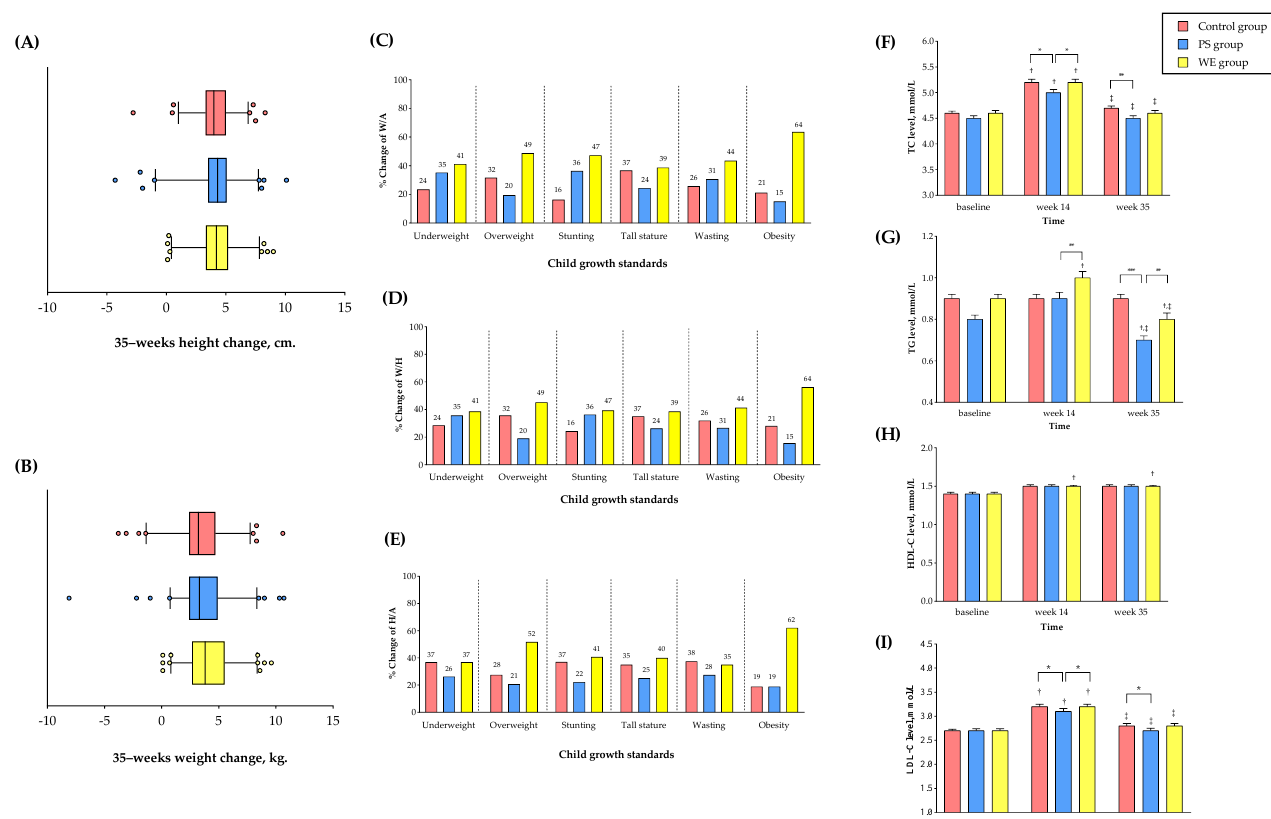
Figure 2. Anthropometrics and plasma lipid levels change in study group. ( A ) Mean of changes in height. ( B ) Mean of changes in weight. ( C ) Percentage of W/A change. ( D ) Percentage of H/A change. ( E ) Percentage of W/H change. ( F ) TC level. ( G ) TG level. ( H ) LDL-C level and ( I ) HDL-C level. The bar graph represents the mean. The error bar indicates the standard error of the mean (SEM). * The statistical significance between the group at p < 0.05. ** The statistical significance between the group at p < 0.01. *** The statistical significance between the group at p < 0.001. † The statistical significance within the group compared to the baseline. ‡ The statistical significance within the group compared to week 14. Abbreviations; PS = protein substitute group; WE = whole egg group; TC = total cholesterol; TG = triglyceride; LDL-C = low-density lipoprotein cholesterol; HDL-C = high-density lipoprotein cholesterol.